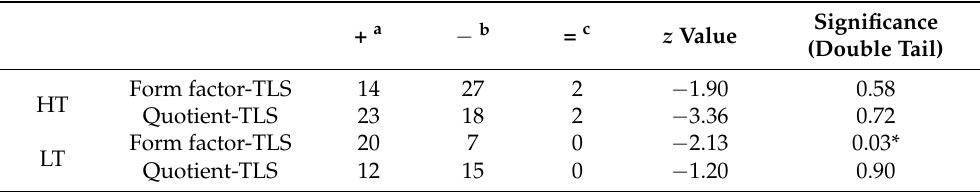
Figure 4. The percentage error (%) in the trunk volume when used at both stand densities was transformed with the universal form factor ( F 1.3 = 0.45) and the quotient conversion. Q n was the result of Section 3.2 and was calculated based on Equation (4). The trunk volume, calculated with the TLS system, was assumed to be accurate. MPE, mean percentage error; MAPE, mean absolute percentage error; TLS, terrestrial laser scanning. Table 3. Wilcoxon symbol grade verification for the form factor volume, quotient conversion volume, and TLS sectional